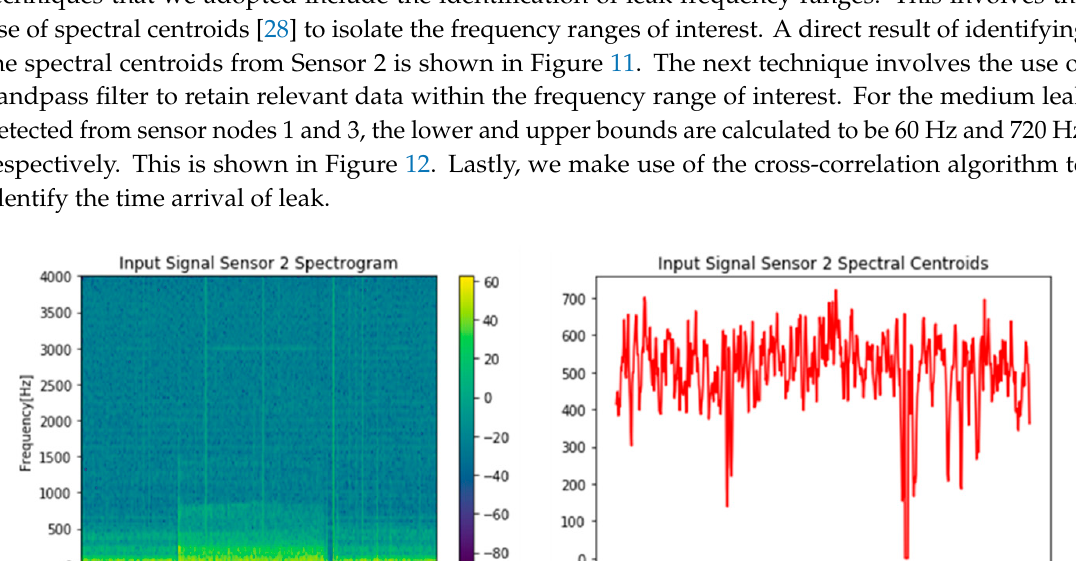
Figure 10. Frequency Analysis of filtered signals.